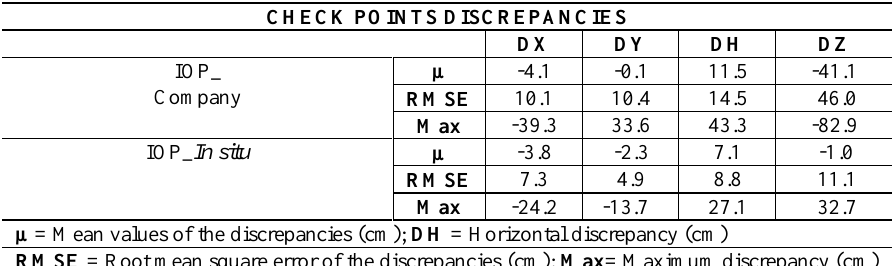
experiment of the second block with control